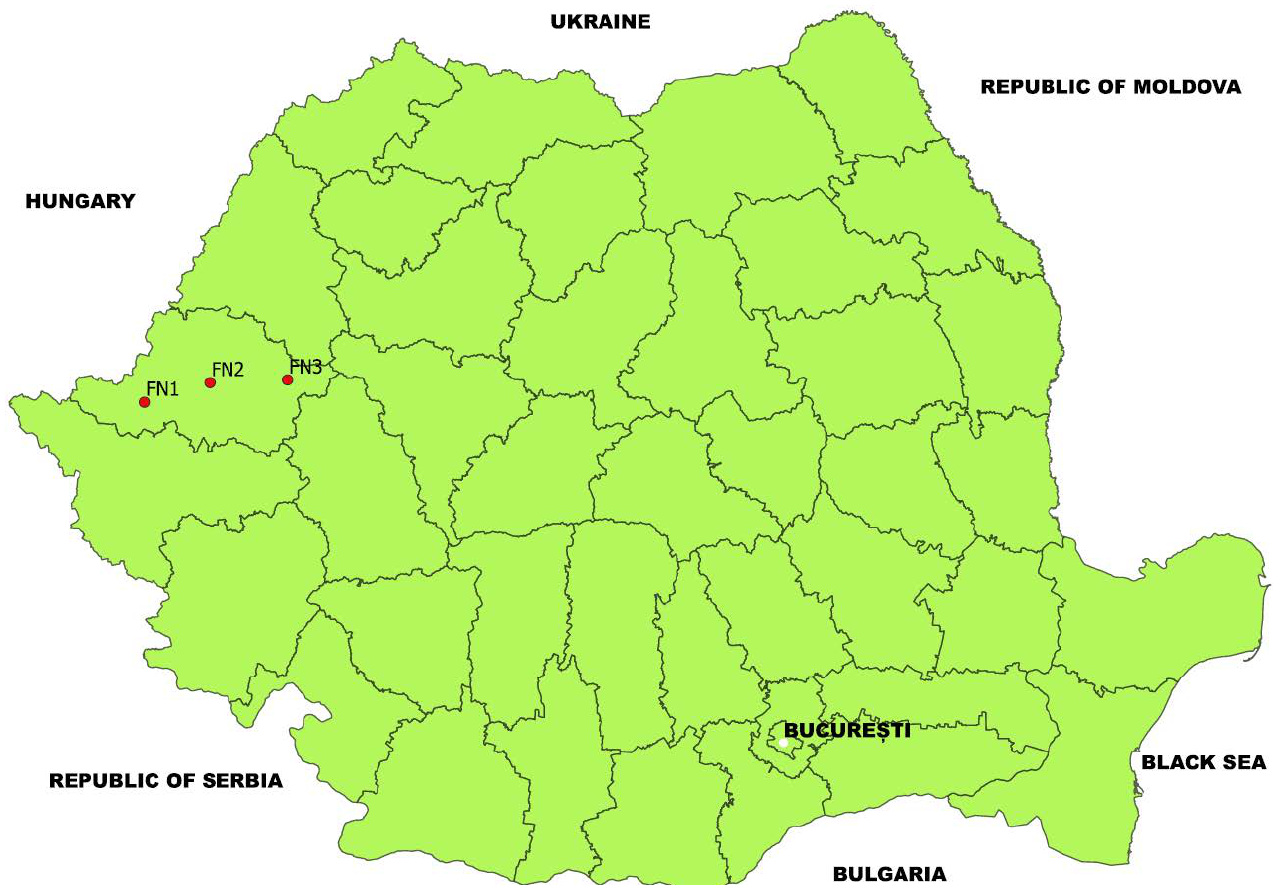
Figure 1. Map of the Romania showing the locations of the forest nurseries taken into study.